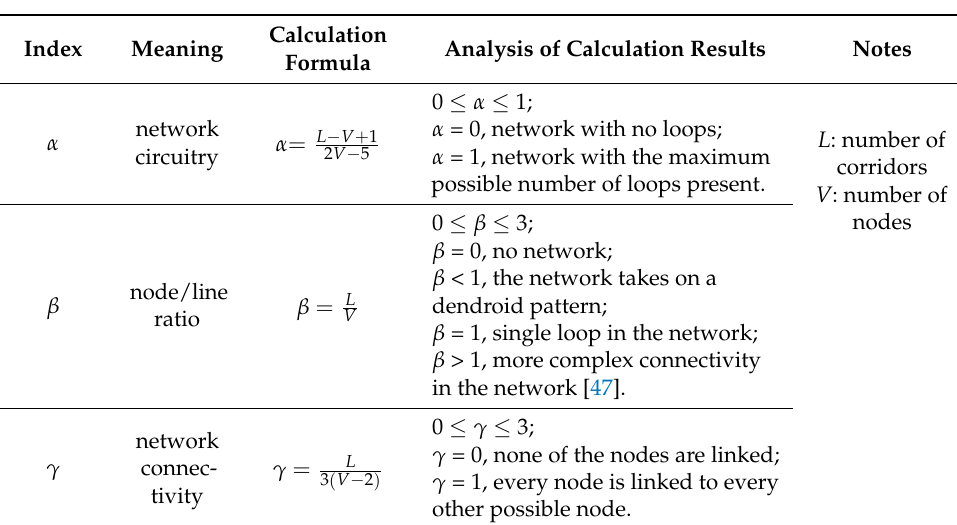
Figure 2. Examples of the common networks ( a )–( f ) by Hellmund. Table 2. Network structure index